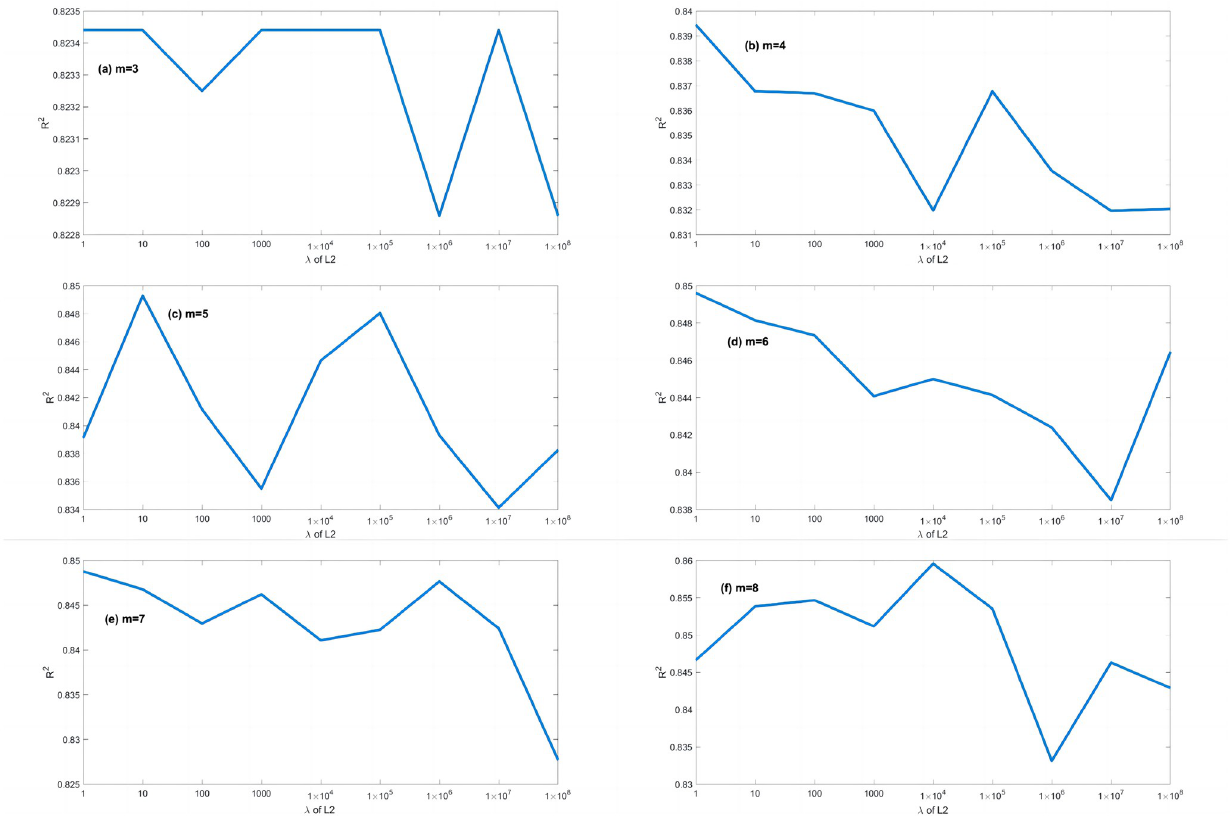
Fig 8. Comparison of EPR results (R 2 ) in different values of λ to L2RM (dataset 2). (a) m = 3, (b) m = 4, (c) m = 5, (d) m = 6, (e) m = 7 and (f) m = 8.